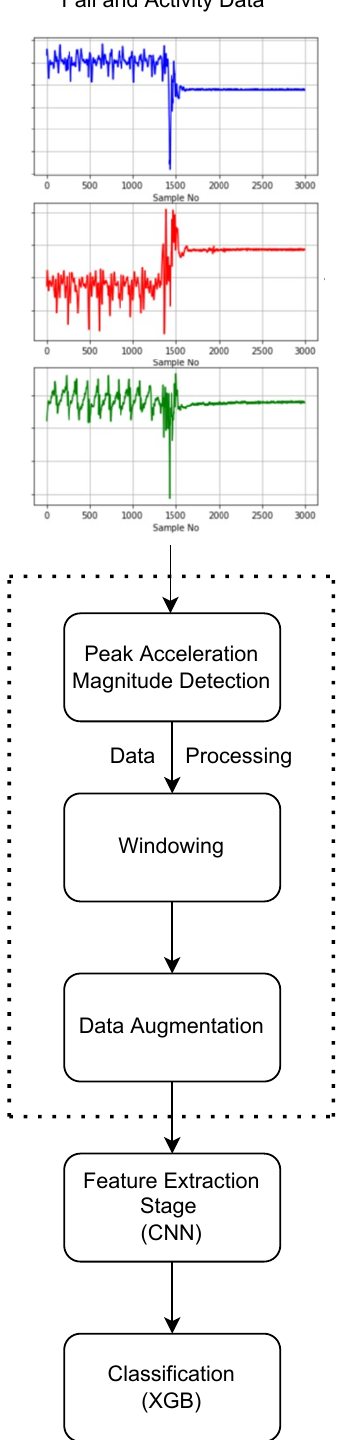
Figure 1. Hierarchical classification scheme for ADL and Fall